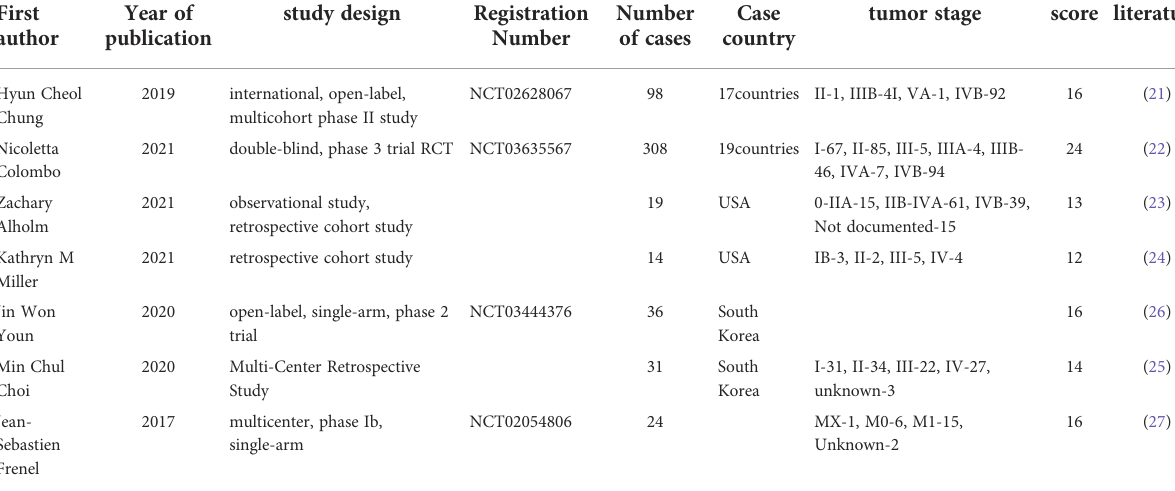
TABLE 2 Characteristic of included studies.